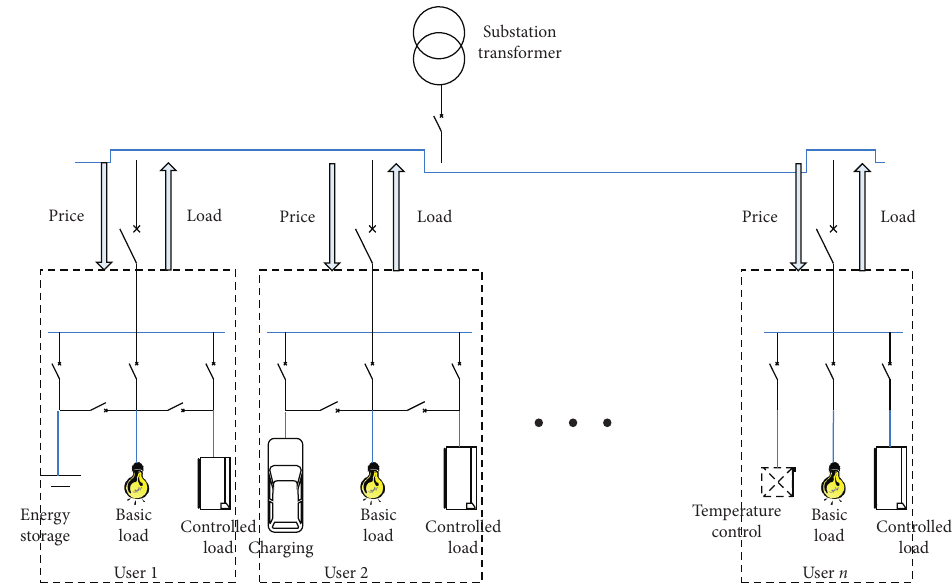
Figure 1: Intelligent bidirectional interactive operation